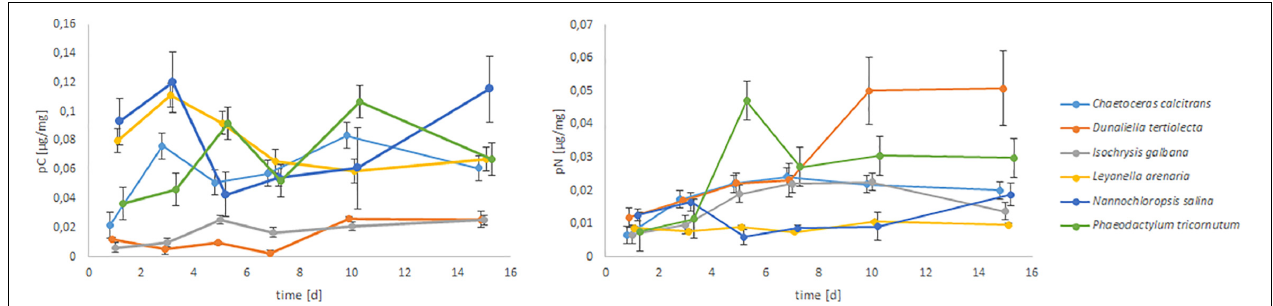
FIGURE 1 | C and N uptake of different food sources (dried algae) by C. selseyense . The datapoints are calculated from n = 3 replicates and the error bars indicate the standard deviation.